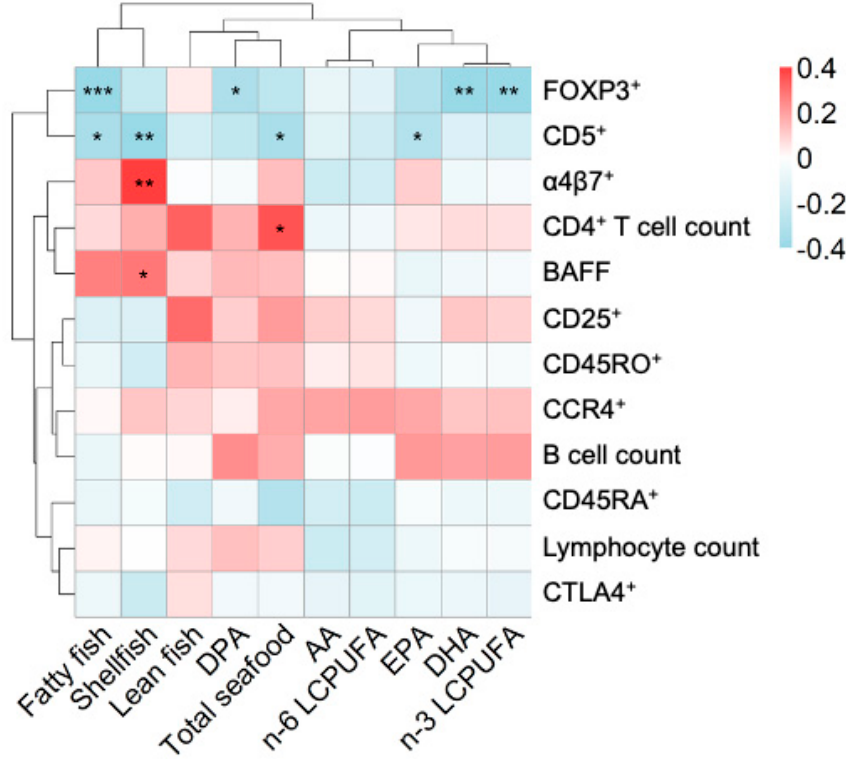
Figure 4. Heatmap showing the correlations between reported maternal seafood intake during pregnancy, fatty acids in cord serum, and immune cells in the cord blood. The magnitude of each correlation is indicated with a color, whereby the red color indicates a positive correlation and the blue color represents a negative correlation. A darker shade of each color indicates a stronger correlation. Levels of statistical significance using Spearman correlations are denoted as: * p < 0.05, ** p < 0.01, *** p < 0.001. Abbreviations: AA, arachidonic acid; EPA, eicosapentaenoic acid; DPA, docosapentaenoic acid; DHA, docosahexaenoic acid; LCPUFA, long-chain polyunsaturated fatty acid; CD25, percentage of CD25 + cells in CD4 + T-cell population; CCR4, percentage of CCR4 cells in CD4 + T-cell population; a4b7, percentage of α 4 β 7 + cell in the of CD4 + T-cell population; CD45RO, percentage of memory CD45RO + cells in the CD4 + T-cell population; FOXP3, percentage of FOXP3 + CD25 high cells in the CD4 + T-cell population; CD45RA, percentage of naive CD45RA + cells in the CD4 + T-cell population; CTLA4, percentage of CTLA-4 + CD25 + cells in the CD4 + T-cell population; BAFF, levels of B cell activating factor.